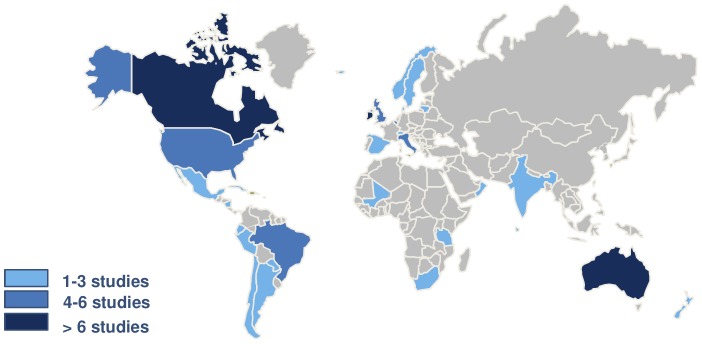
Distribution of the 73 articles on Robson's classification according to country of origin.